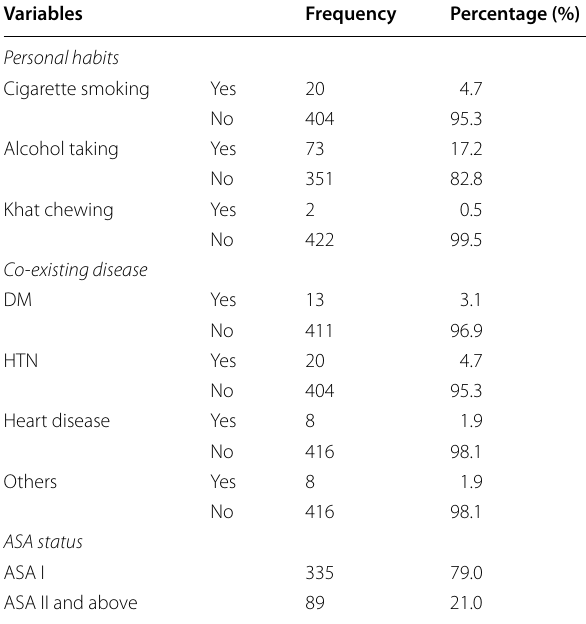
Table 2 Preoperative personal habits and health status of postoperative surgical